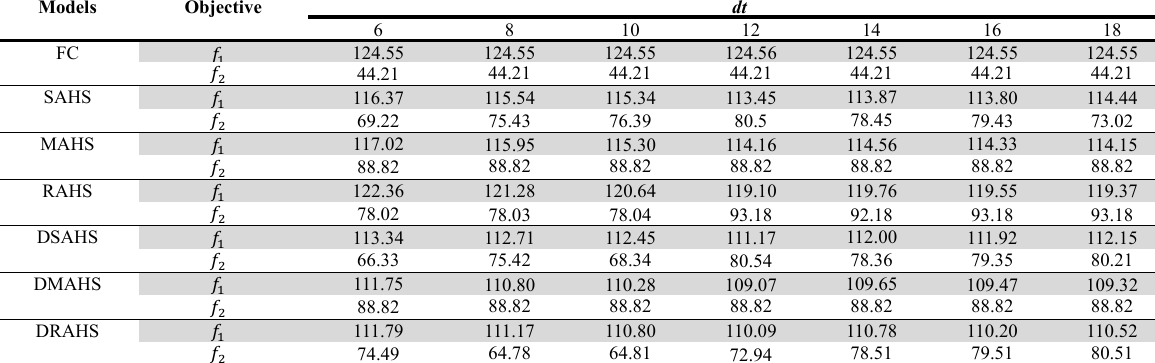
Table 13 Performance of optimal solutions for different value of dt Models